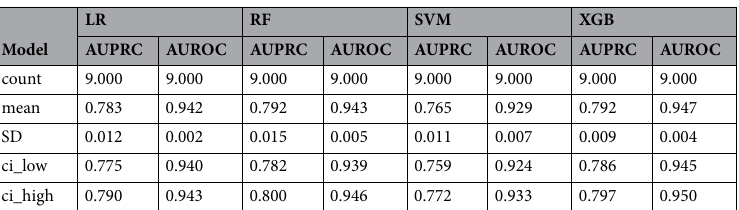
Table 3. Model performances of difference machine learning algorithms. ci_low Lowest 95% confidence interval of experiments, ci_high Highest 95% confidence interval of experiments, SD Standard Deviation, AUPRC Area Under Precision-Recall Curve, AUROC Area Under Receiver-Operator